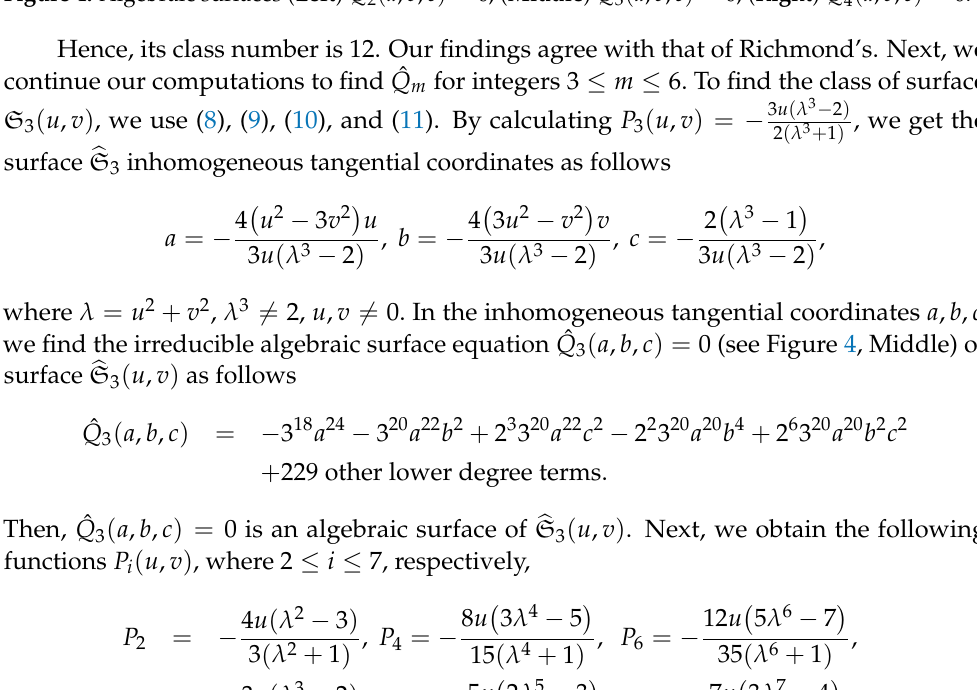
Figure 4. Algebraic surfaces ( Left ) ˆ Q 2 ( a , b , c ) = 0, ( Middle ) ˆ Q 3 ( a , b , c ) = 0, ( Right ) ˆ Q 4 ( a , b , c ) =